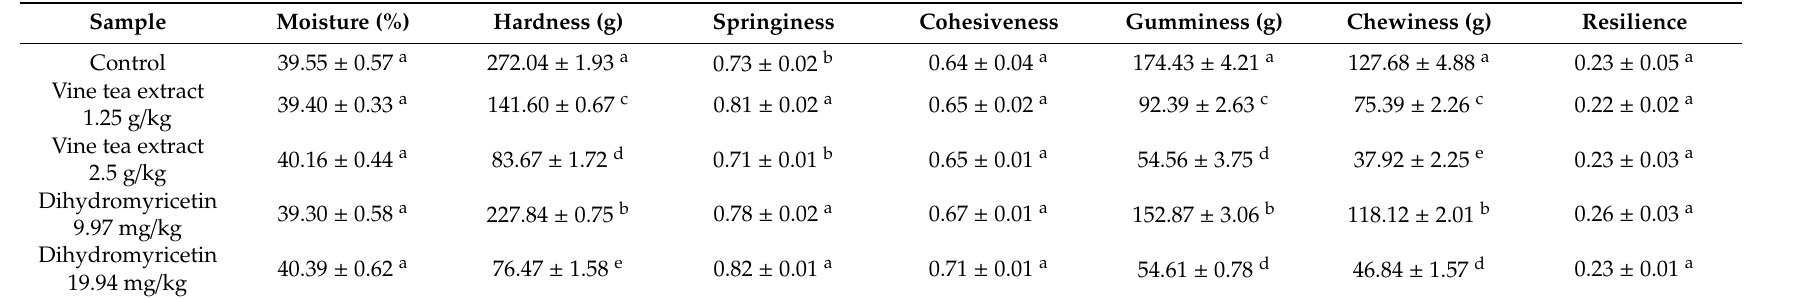
Table 3. Texture profiles and moisture contents of bread crumb treated with or without vine tea extracts or